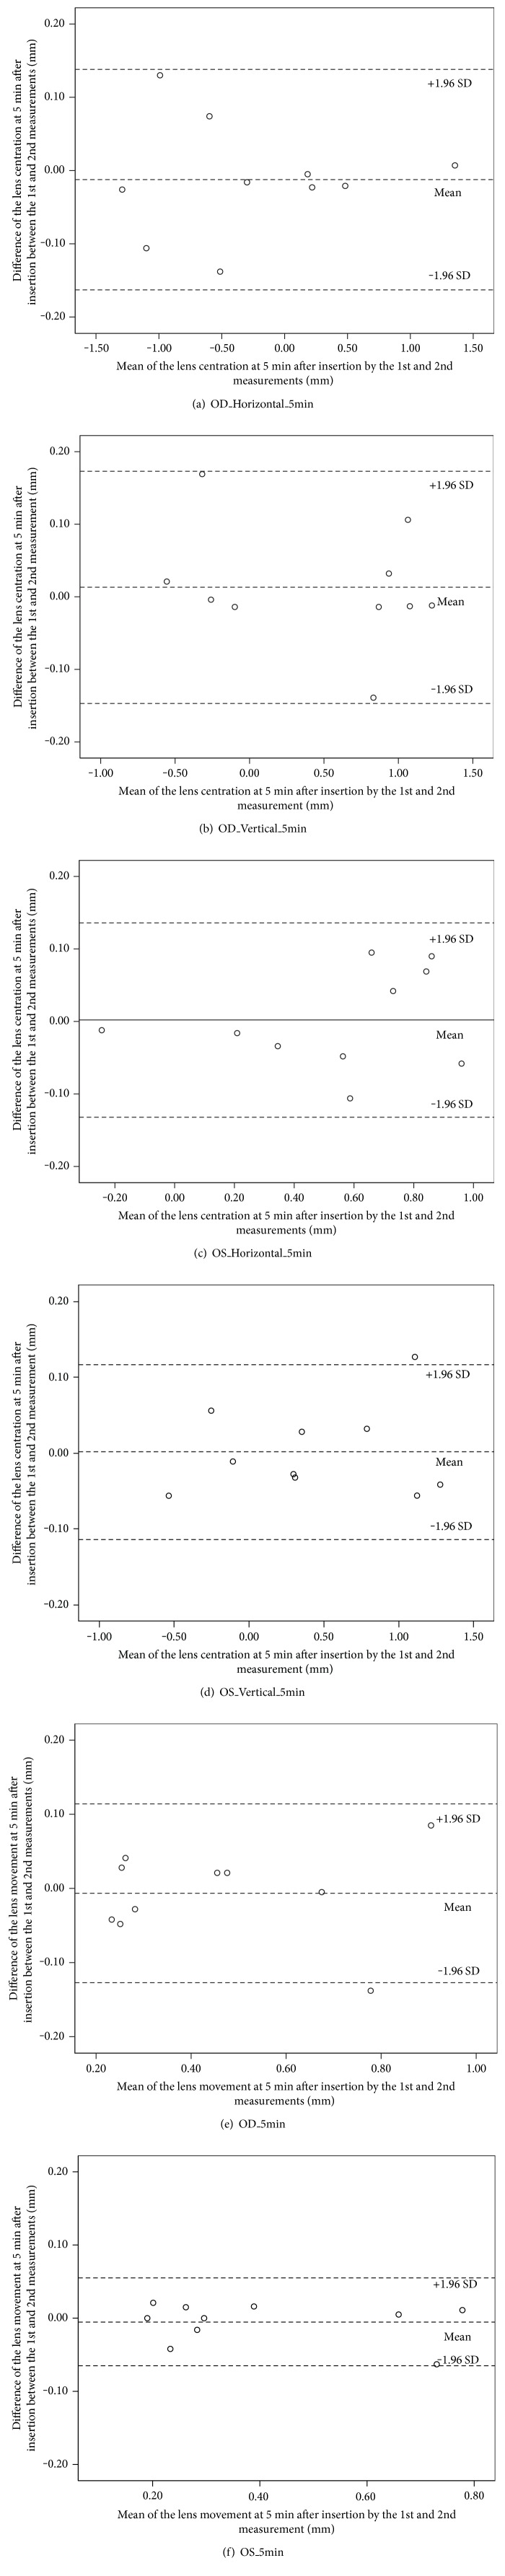
Bland-Altman plots of the differences between two measurements of the lens centration and movement at 5 min after insertion. The mean differences of the variables between two repeated measurements for lens centration (a)–(d) at both meridians and the blink induced (e)-(f). The mean differences in the values between the two measurements were around approximately zero, and the 95% confidence limits were represented by the dotted lines. OD: the right eye; OS: the left eye.